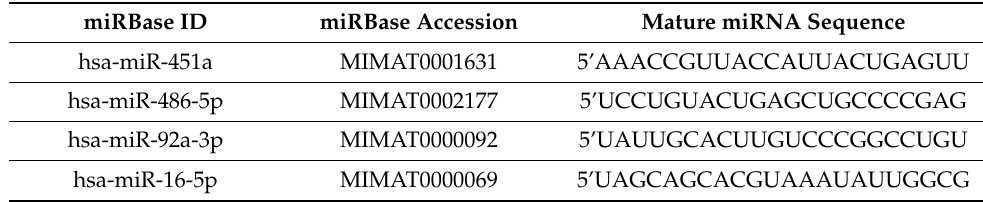
Table 1. Primers used for quantitative